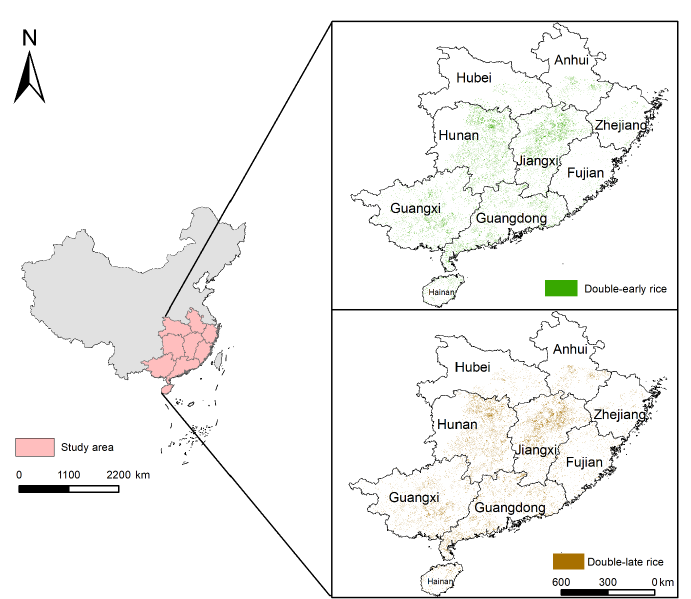
Figure 1. Study area and spatial distribution of double cropping rice in south China. The hourly ground-level ozone concentration data from 2013 to 2019 were acquired from the Chinese Air Quality Reanalysis (CAQRA) dataset [45], which was generated by the Institute of Atmospheric Physics, Chinese Academy of Sciences (IAP, CAS). The CAQRA dataset provided the surface gridded fields of six conventional air pollutants